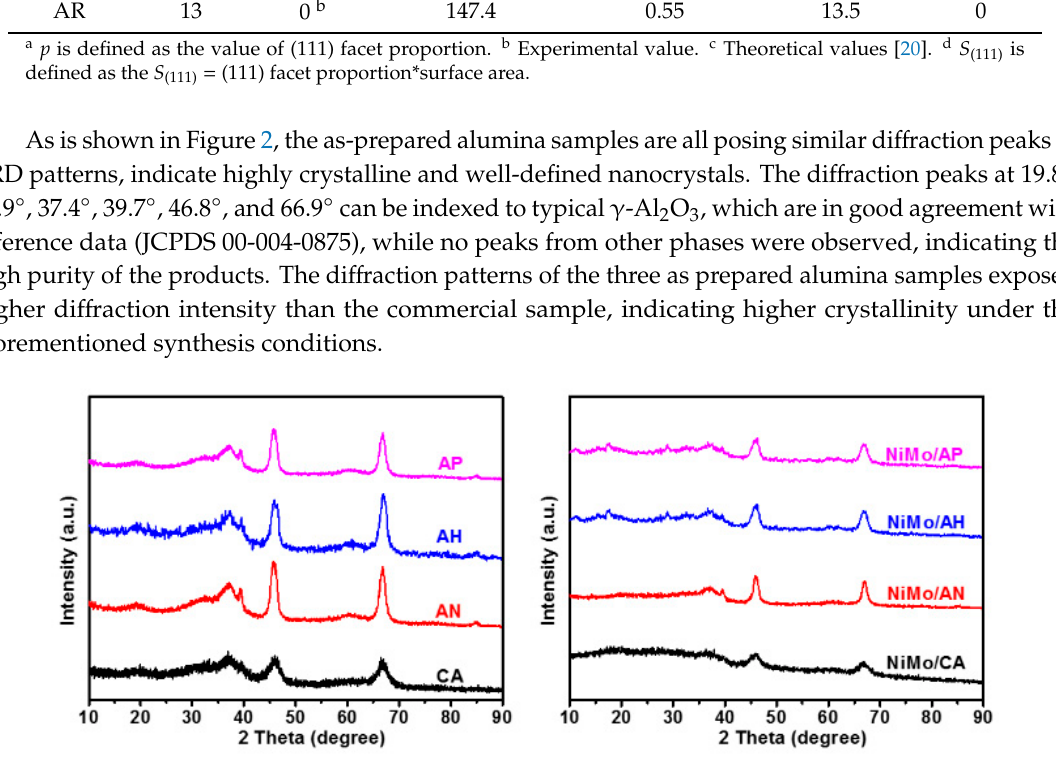
Figure 2. XRD of the Al 2 O 3 ( left ) and NiMo/Al 2 O 3 ( right ) samples.